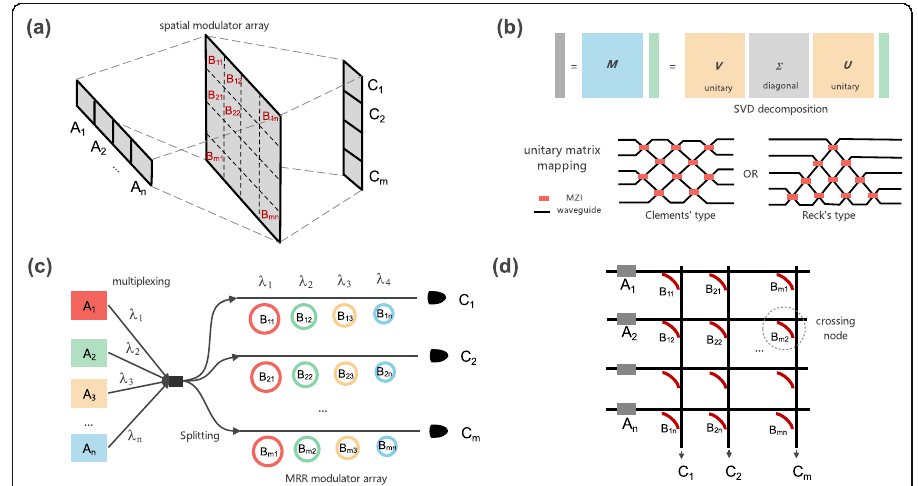
Fig. 1 Optical vector matrix multipliers. a Vector matrix multiplier based on spatially separated devices. A i , B i , C j and i represent input data, matrix element and computing result, respectively. b SVD decomposition. Here, V , Σ and U represent a unitary matrix, a diagonal matrix and a unitary matrix, respectively. Each unitary matrix can be uploaded into either Clement ’ s structure or Reck ’ s structure. c Scheme of VMM chip based on wavelength division multiplexing and micro-ring array. A i , B i , j and C i represent input data, matrix element and computing result, respectively. d ‘ Cross-bar ’ scheme of VMM implemented by on-chip micro-comb and PCM modulator matrix. A i , B i , j and C i represent input data, matrix element and computing result,